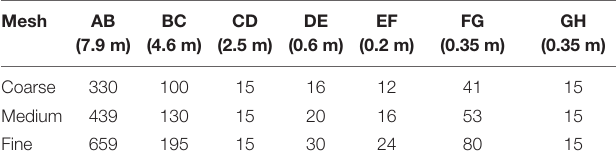
TABLE 1 | Summary of grid parameters in the 2-D models.